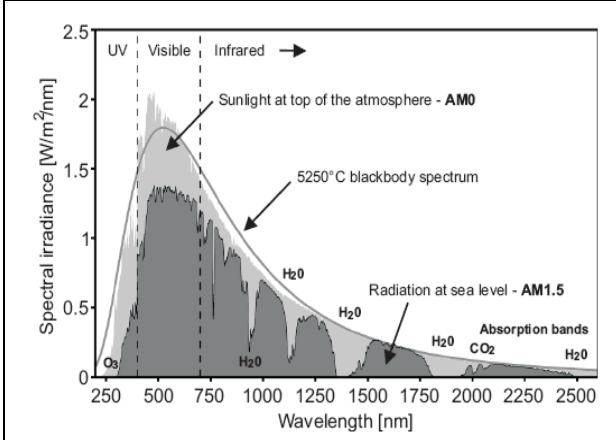
Figure 2.Solar radiation